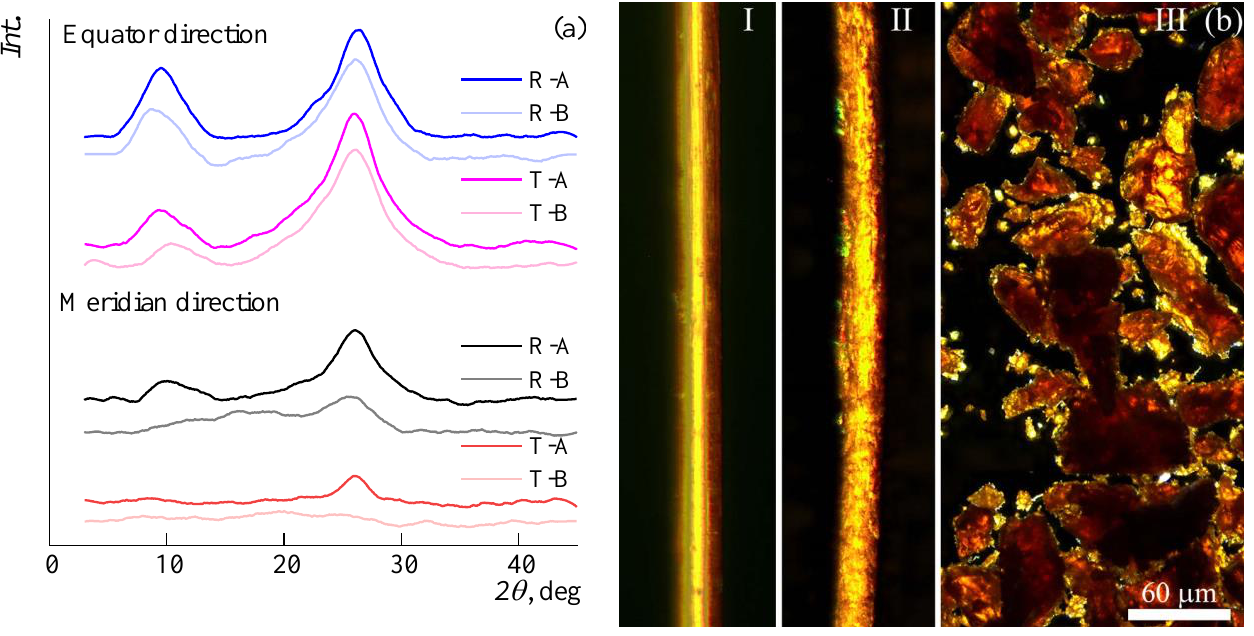
Figure 7. ( a ) X-ray diffraction patterns of ABPBI fibers in equator and meridian directions before (B) and after (A) partial dissolution at reflection (R) and transmission (T) modes; ( b ) ABPBI fiber before (I) and after (II) partial dissolution, and the powder (III) images in linear crossed